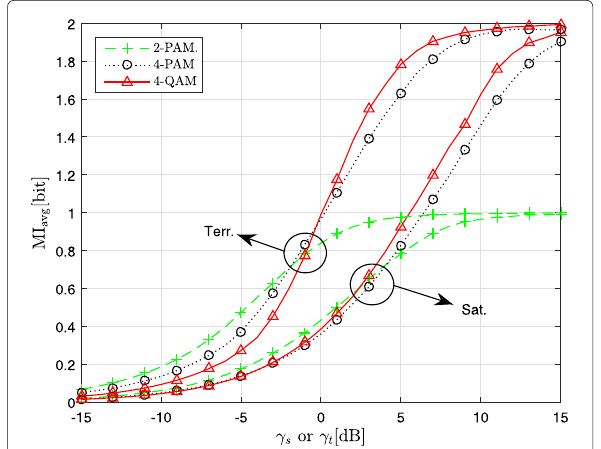
Fig. 8 Best performance (over LP and optimized AD) for the different constellations on terrestrial and satellite